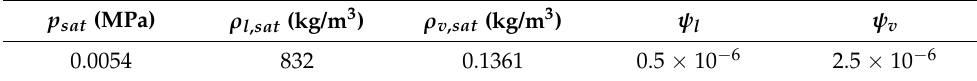
Table 3. Thermodynamic properties of Diesel